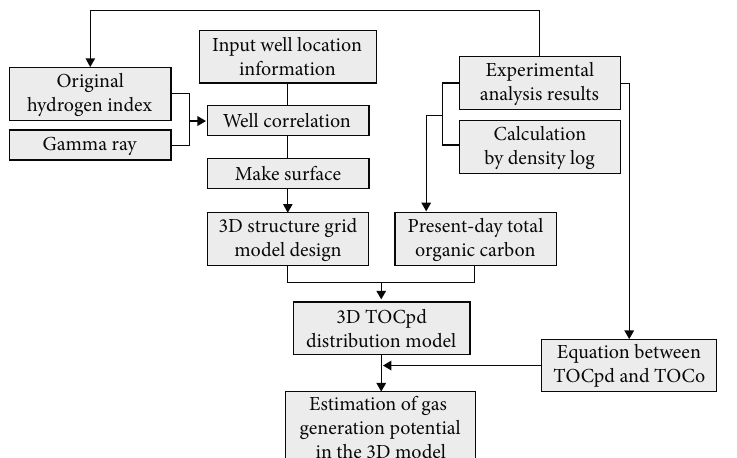
Figure 2: 3D static geochemical modeling work fl ow.